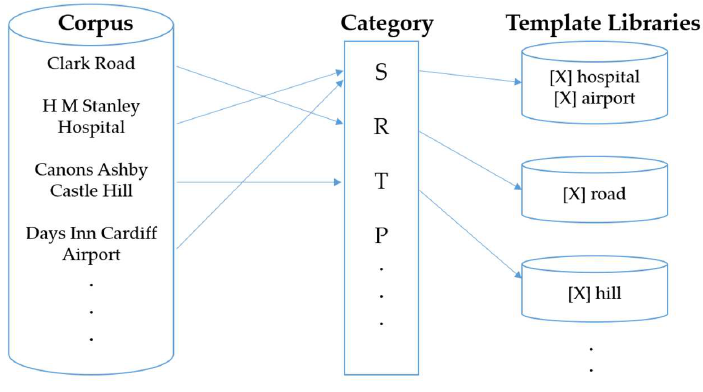
Figure 2. Creating template libraries based on categories of geographical names.